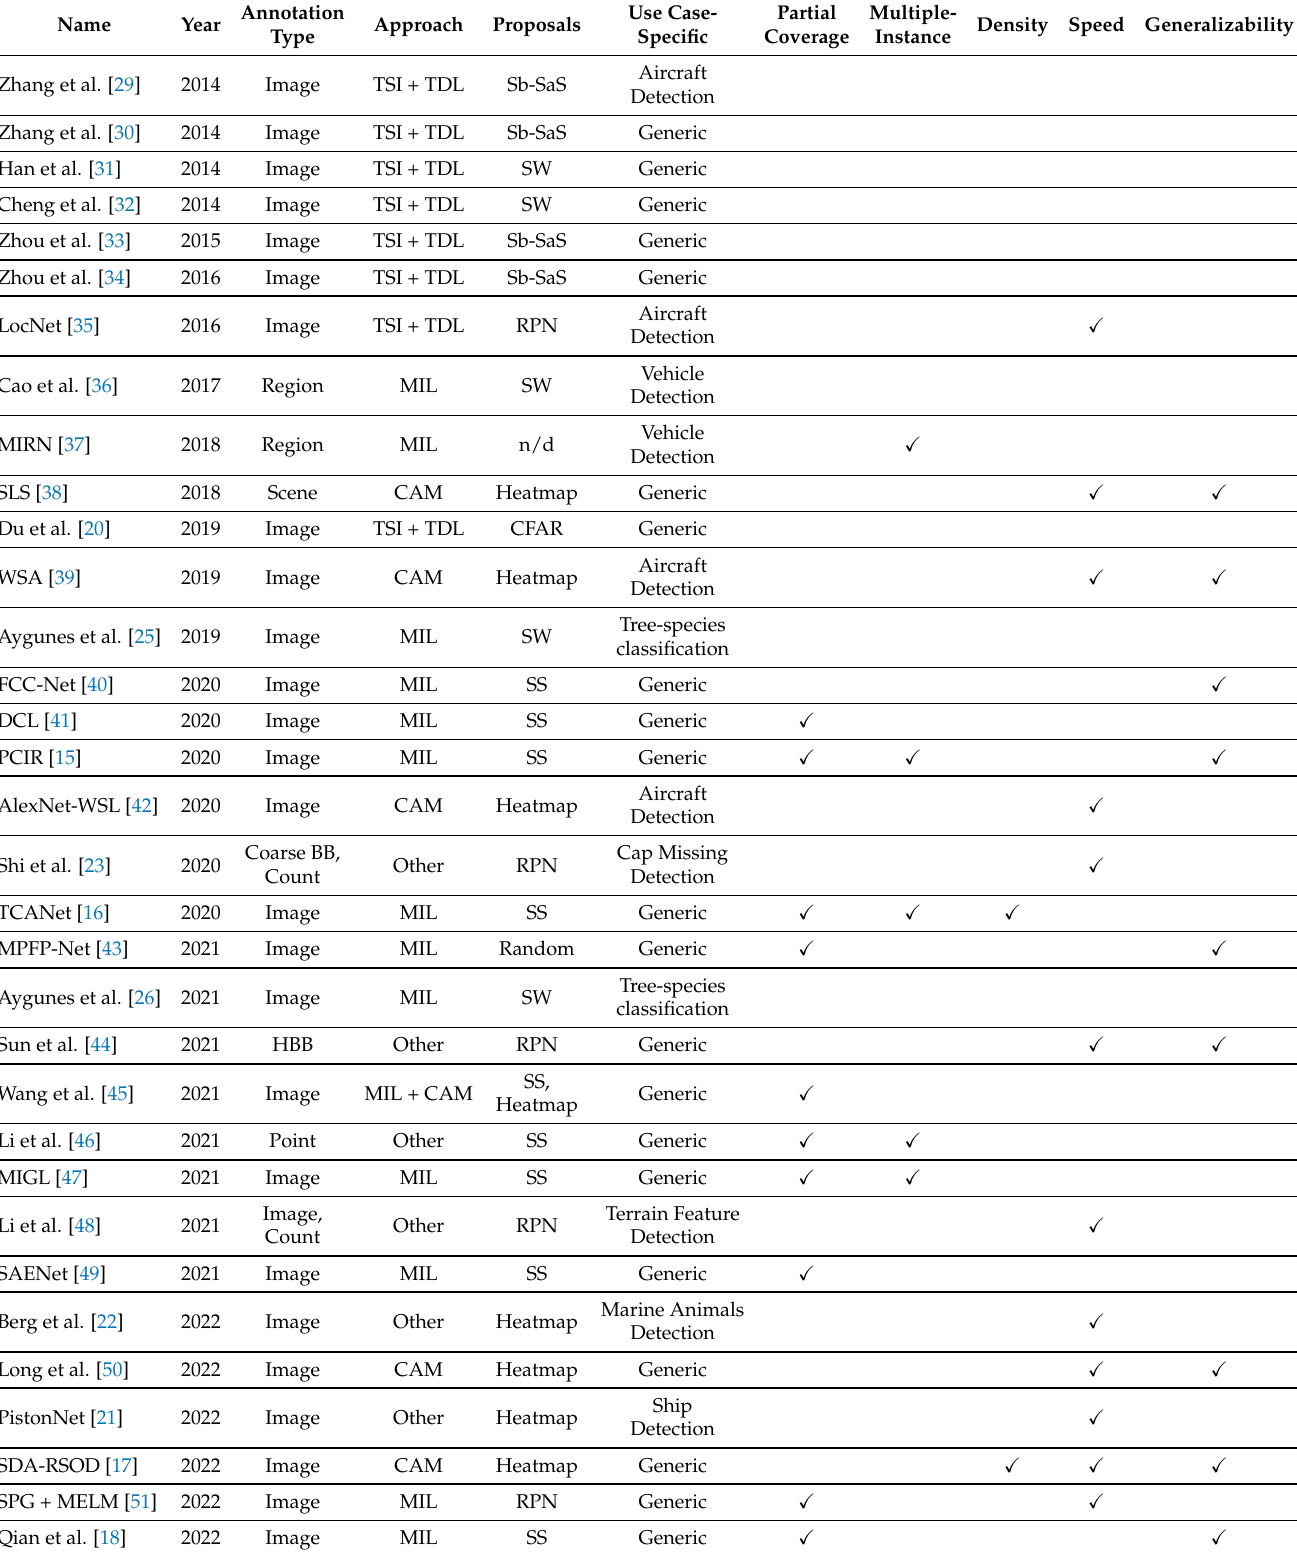
Table 1. A summary of surveyed RSWSOD methods and of the main RSI challenges they address. The (cid:88) symbol means that the work addresses the specific problem listed in the column. No check marks denote the works that study RSWSOD in general without focusing on specific